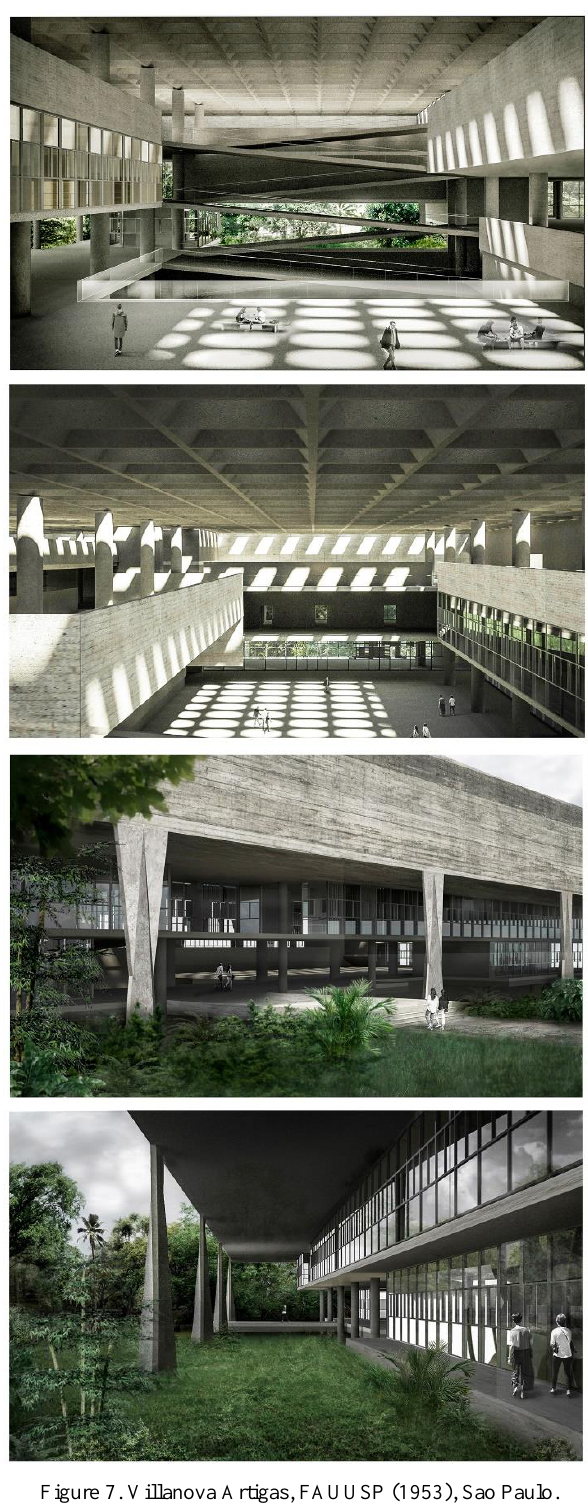
Figure 7. Villanova Artigas, FAUUSP (1953), Sao Paulo. Interior and exterior renderings